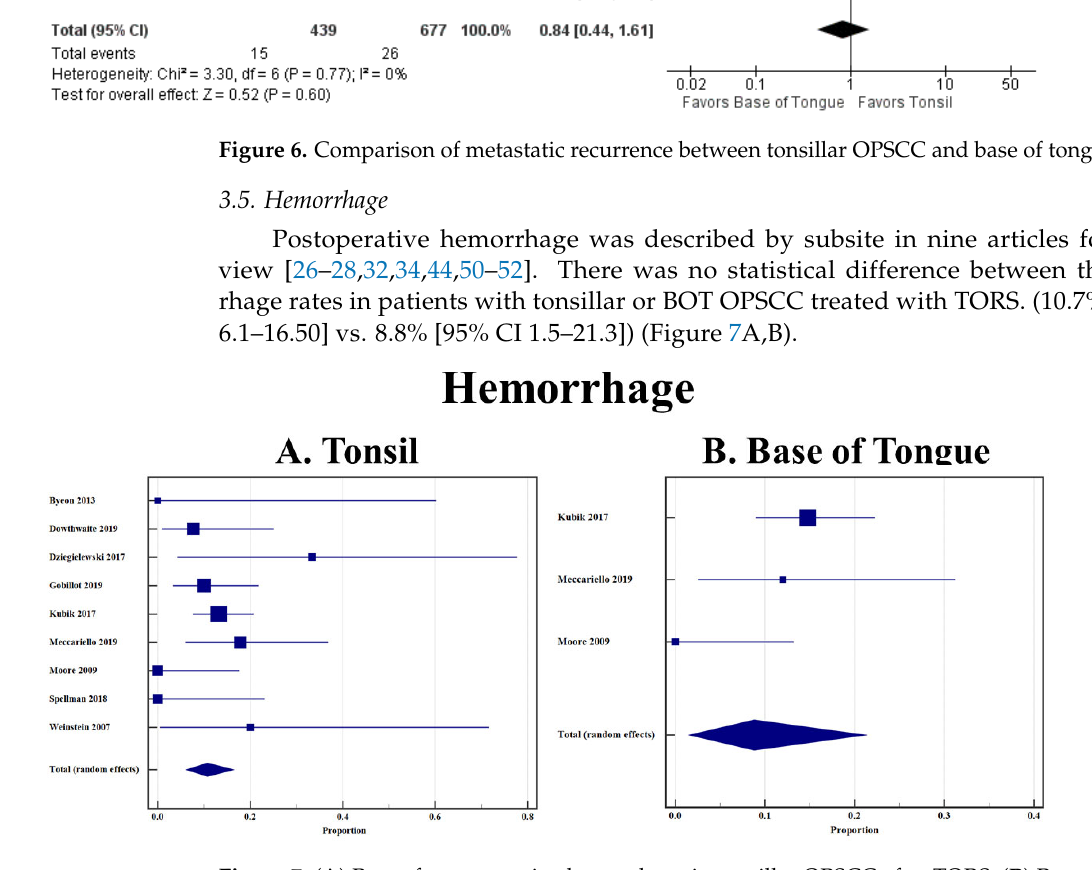
Figure 7. ( A ) Rate of postoperative hemorrhage in tonsillar OPSCC after TORS; ( B ) Rate of postop ‐ erative hemorrhage in base of tongue OPSCC after